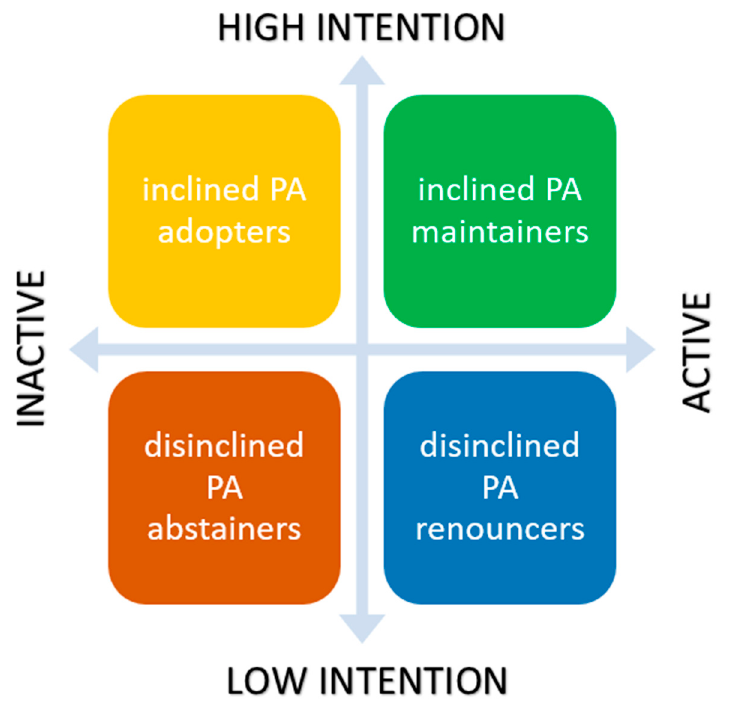
Figure 2. Pregnancy physical activity profiling.